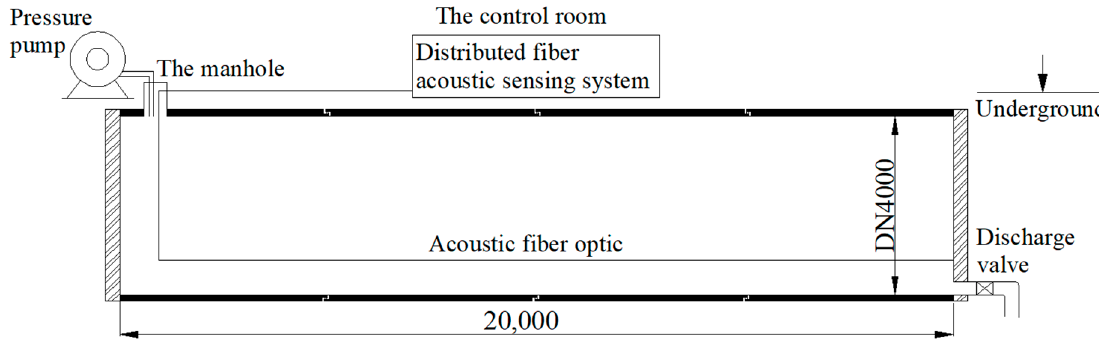
Figure 4. Sketch of the test setup.